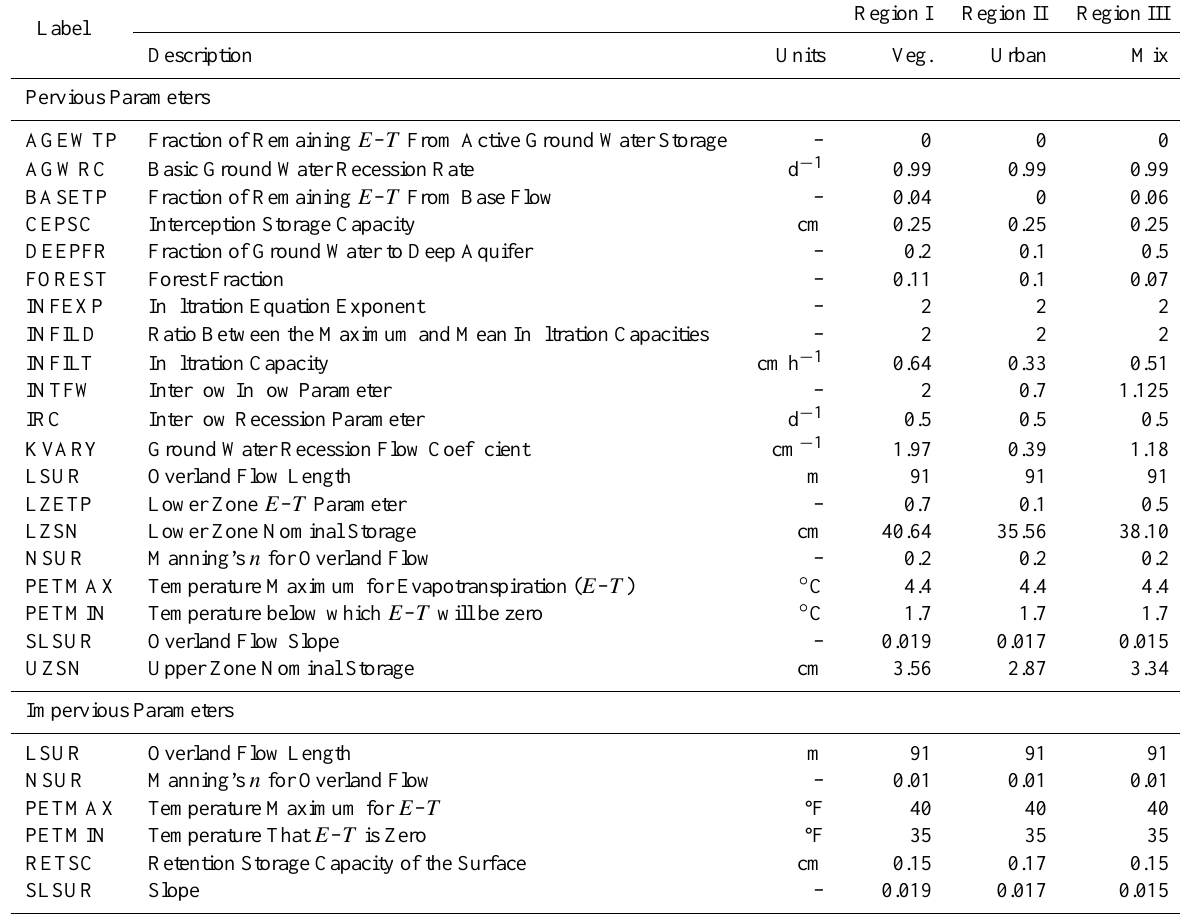
Table 2. Final model parameters used for discharge simulations in archetypal